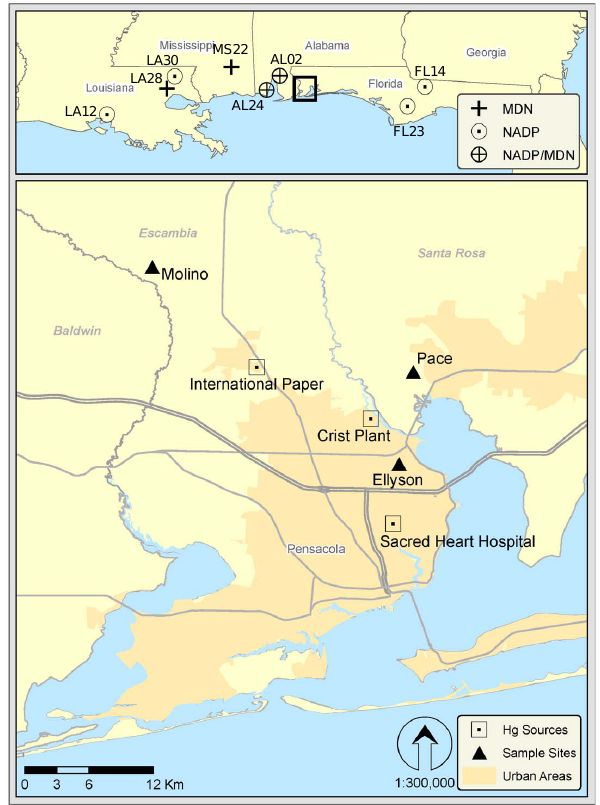
Fig. 1. Map of Pensacola Bay showing sampling locations: Ellyson, Molino and Pace. Mercury emission sources: Crist Plant, Interna- tional Paper, Sacred Heart Hospital medical waste incinerator. Inset map shows location of Mercury Deposition Network (MDN) and National Atmospheric Deposition Program (NADP) sampling sites along the central Gulf